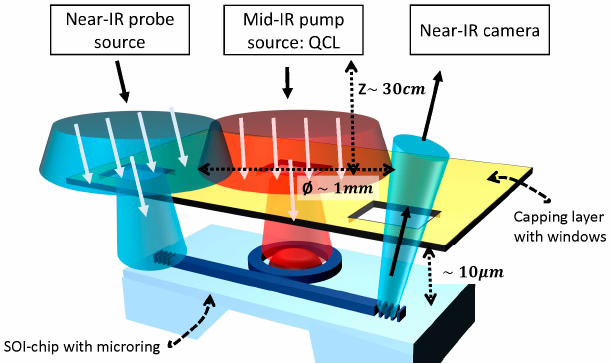
Figure 17. Schematic of a possible free-space measurement configuration. The probe and pump sources flood-illuminate the chip from a certain distance, e.g., 30 cm. The SOI-chip is capped with a reflective or absorbing second layer (e.g., gold-coated silicon) with spacers (not shown in schematic). Small apertures (uncoated areas of the capping layer) are aligned on top of the MRR and the input/output ports of the probe. The probe signal is collected by a near-IR camera.